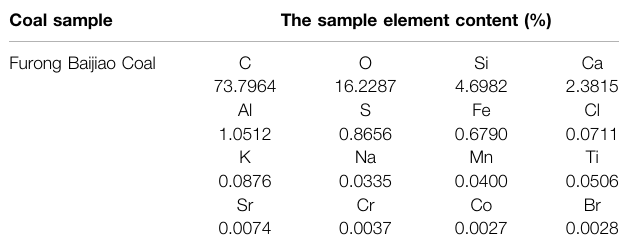
TABLE 1 | X-ray fl uorescence analysis of coal and rock.